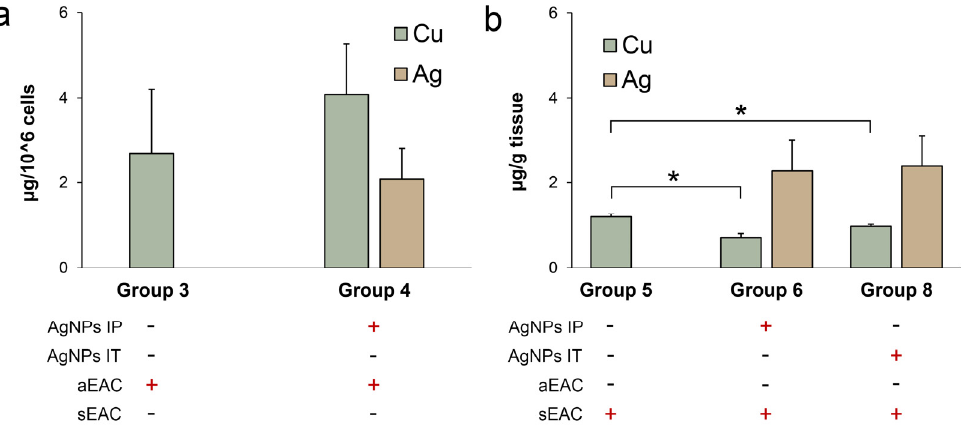
Figure 9. Copper (green bars) and silver (brown bars) concentration in ascitic ( a ) and solid ( b ) EAC. Numbering of groups is the same as in Table 1. *: p < 0.05 compared to group 5.